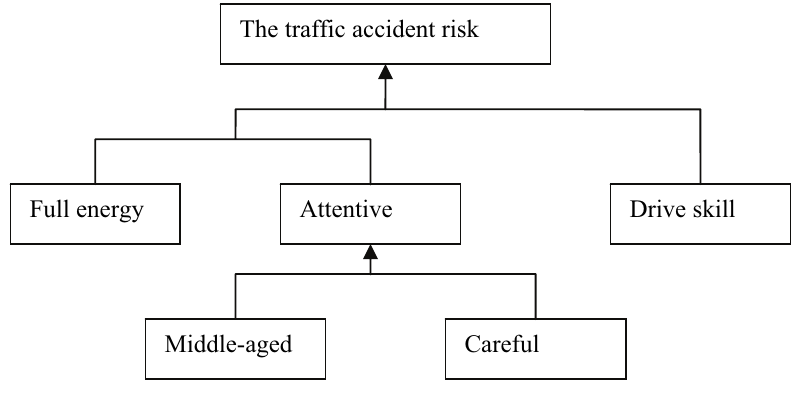
Fig. 2 The traffic accident risk